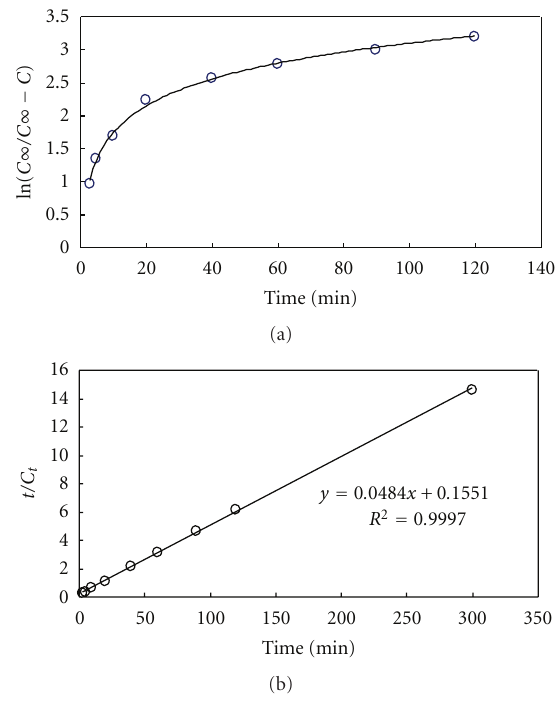
Figure 5: Result of first-order (a) and second-order (b) plots of lipid extraction from Scenedesmus sp. with homogenization